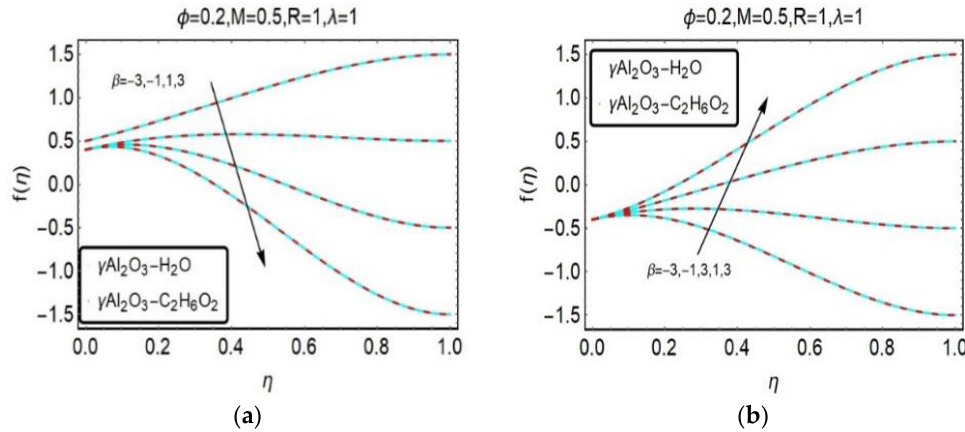
Figure 3. Influence of 𝛽 on 𝑓(𝜂) for ( a ) 𝑆 > 0 and ( b ) 𝑆 < 0 .